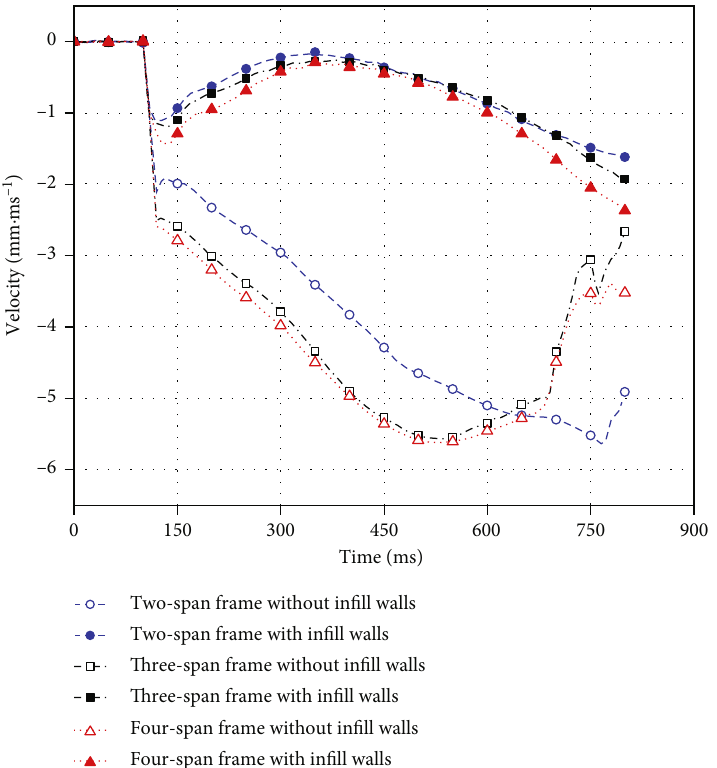
Figure 19: The z -direction velocity at the apex of the bottom side